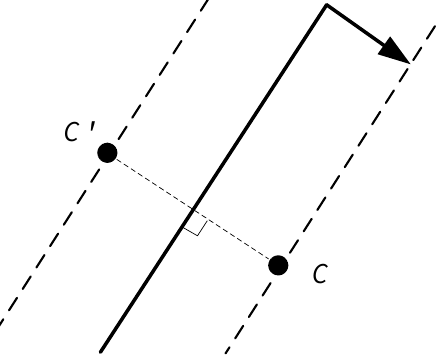
Figure 10. Judging the location of the point